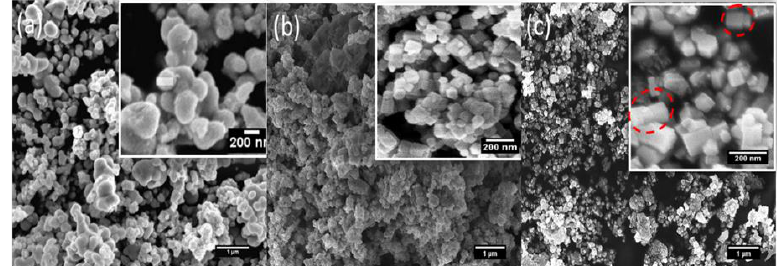
Figure 2. The SEM images of ( a ) 3ZT-CO, ( b ) 3ZT-CO/Neem, and ( c ) 3ZT-CO/PVA.